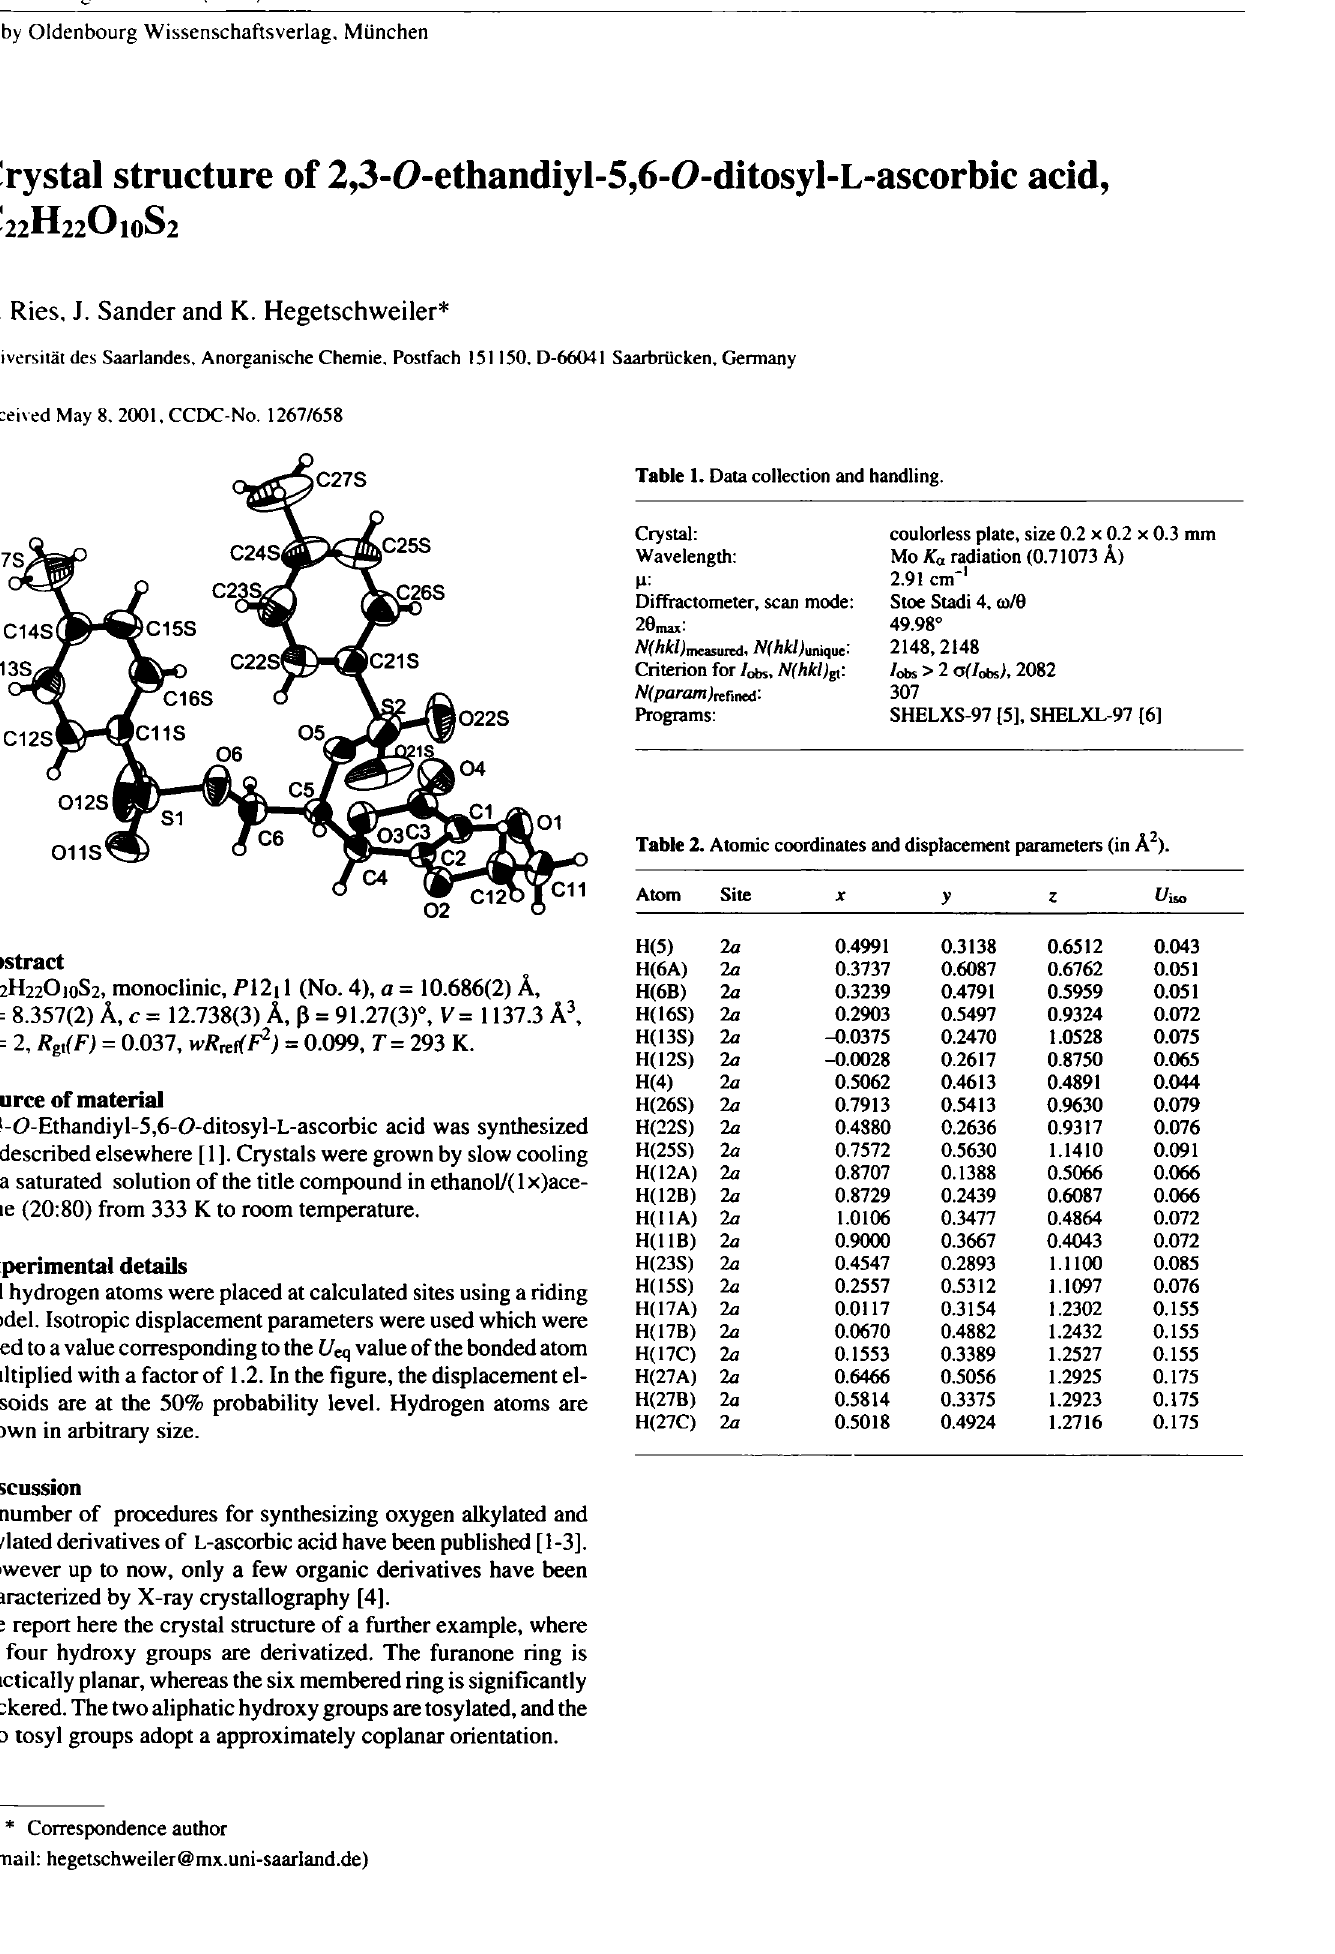
Table 1. Data collection and handling.